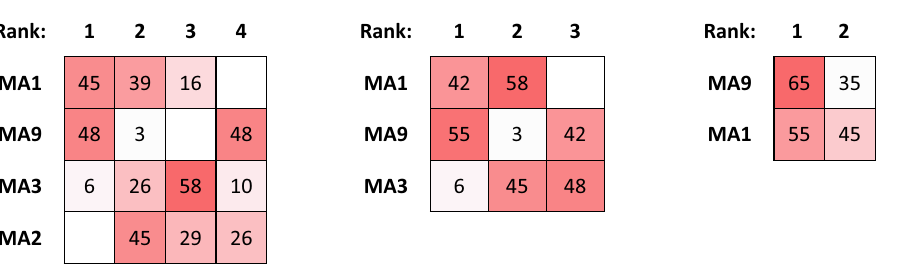
Figure 5. Progressive Ranking Strength through